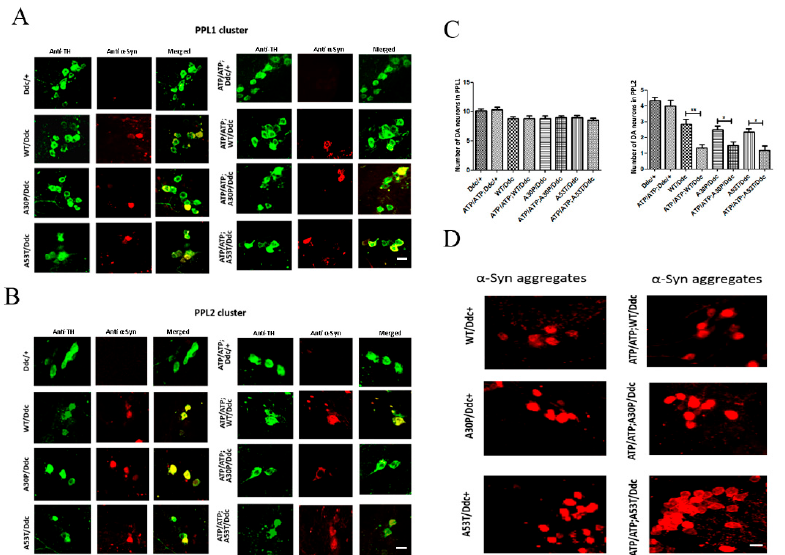
Figure 4. Neurodegeneration in ATP13A2 silencing flies expressing α -syn. Representative image of projected Z-series of PPL1 ( A ) and PPL2 ( B ) clusters in 30-day-old fly brains under the control of Ddc- Gal4 driver. The image shows co-staining of anti-TH (green) and anti-syn antibody (red) antibodies, revealing only a few neurons expressing α -syn in the PPL1 cluster compared to abundant expression in the PPL2 cluster in different genotypes under the Ddc-Gal4 driver. ( C ) Relative number of DA neurons within the PPL1 and PPL2 cluster of ATP13A2-silenced 30-day-old flies with Ddc-Gal4 driver-expressing WT, A30P, and A53T α -syn (n = 12) compared to age-matched control flies without ATP13A2 RNAi (n = 12). Differences in means were compared using one-way ANOVA followed by the Newman–Keuls Multiple Comparison post hoc test. ** p < 0.001; * p < 0.05. ( D ) Representative immunofluorescent staining of 30-day-old fly brain expressing WT, A30P, and A53T α -syn with or without ATP13A2 RNAi under Ddc-Gal4 driver stained for α -syn aggregates-specific antibody, showing a gross increase in aggregates in α -syn mutants, especially A53T, during ATP13A2 silencing. Scale bar 10 µ